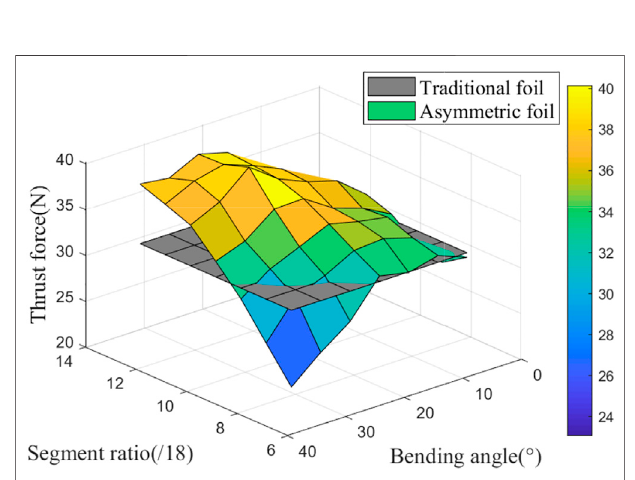
FIGURE 6 | Thrust force of the asymmetric foil with different parameter pairs (segment ratio and bending angle) at the lower limit angle 45 ° , with a constant fl ow speed 40 cm / s